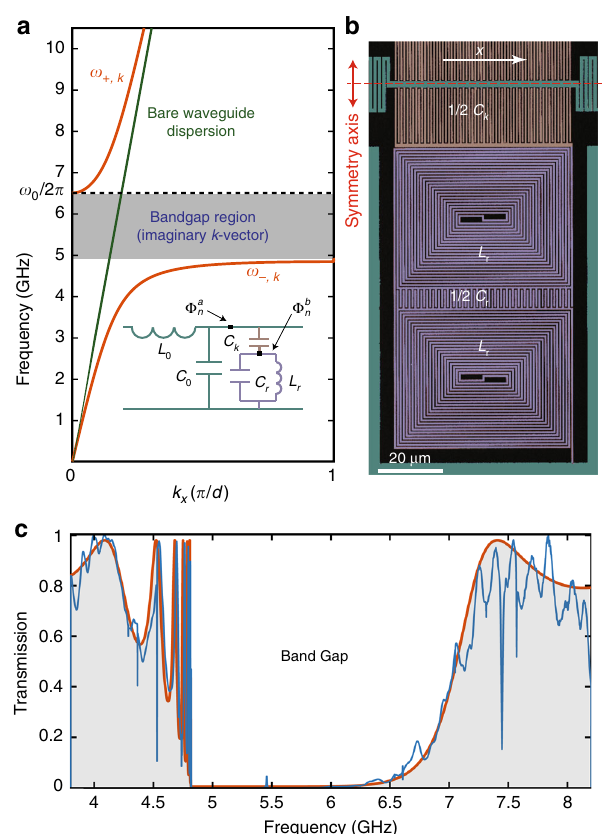
Fig. 1 Microwave metamaterial waveguide. a Dispersion relation of a CPW loaded with a periodic array of microwave resonators (red curve). The green line shows the dispersion relation of the waveguide without the resonators. Inset: circuit diagram for a unit cell of the periodic structure. b Scanning electron microscope (SEM) image of a fabricated capacitively coupled microwave resonator, here with a wire width of 500 nm. The resonator region is false-colored in purple, the waveguide central conductor and the ground plane are colored green, and the coupling capacitor is shown in orange. We have used pairs of identical resonators symmetrically placed on the two sides of the transmission line to preserve the symmetry of the structure. c Transmission measurement for the realized metamaterial waveguide made from 9 unit cells of resonator pairs with a wire width of 1 μ m, repeated with a lattice constant of d = 350 μ m. The blue curve depicts the experimental data and the red curve shows the lumped-element model fi t to the